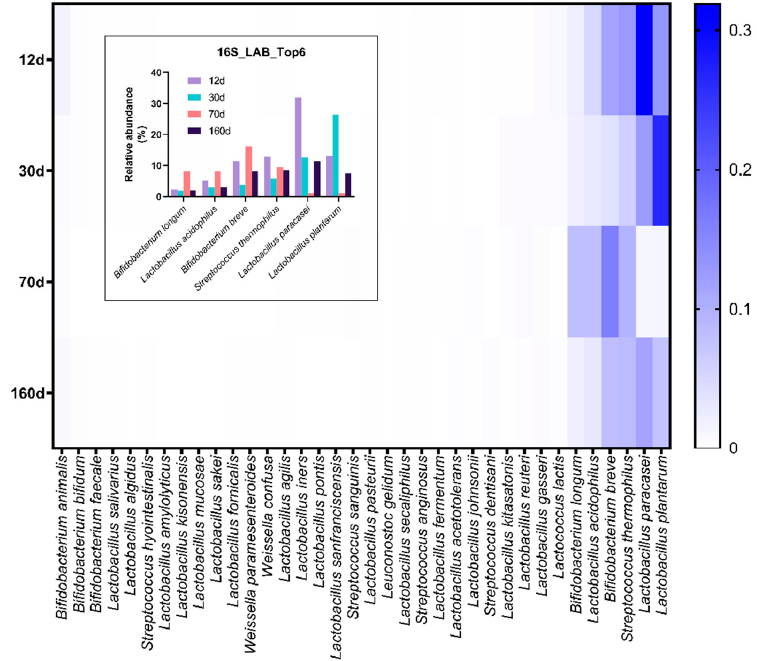
Figure 7. Heatmap of lactic acid bacterial abundance on the surface of dry-aged beef with respect to the aging periods. The blue–white color system was used to represent the relative abundance of each bacterial strain belonging to the families Bifidobacteriaceae, Lactobacillaceae , and Streptococcaceae . Inset: relative abundance (%) of the most dominant lactic acid bacterial species on dry-aged beef.